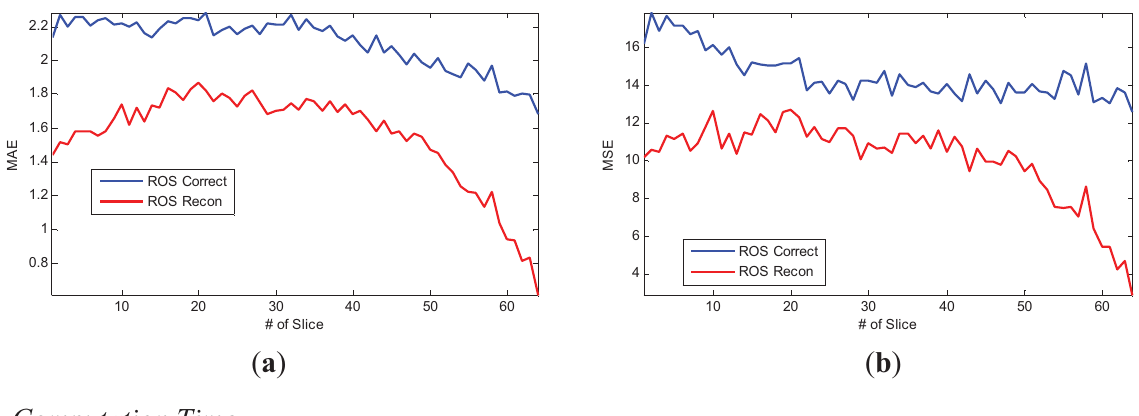
Figure 7. 3D Brain Reconstruction Results: ( a ) MAE curve, ( b ) MSE curve. X-axis denotes the index of brain slices, and y-axis denotes the error values.